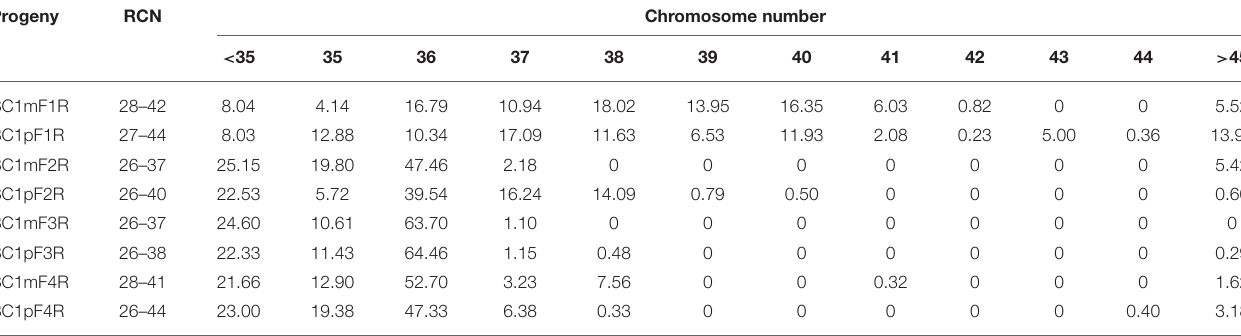
TABLE 1 | Average percentage of ovary cells with different chromosomes in the glyphosate-tolerance first- to fourth-generation progenies of BC1. Progeny RCN Chromosome